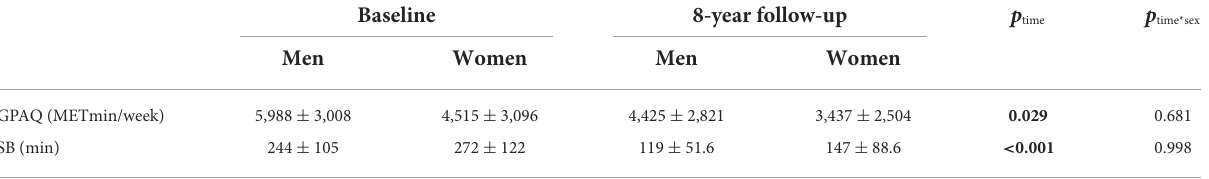
TABLE 3 Self-reported physical activity and sedentary behavior (SB) at the baseline and in follow up measurements.